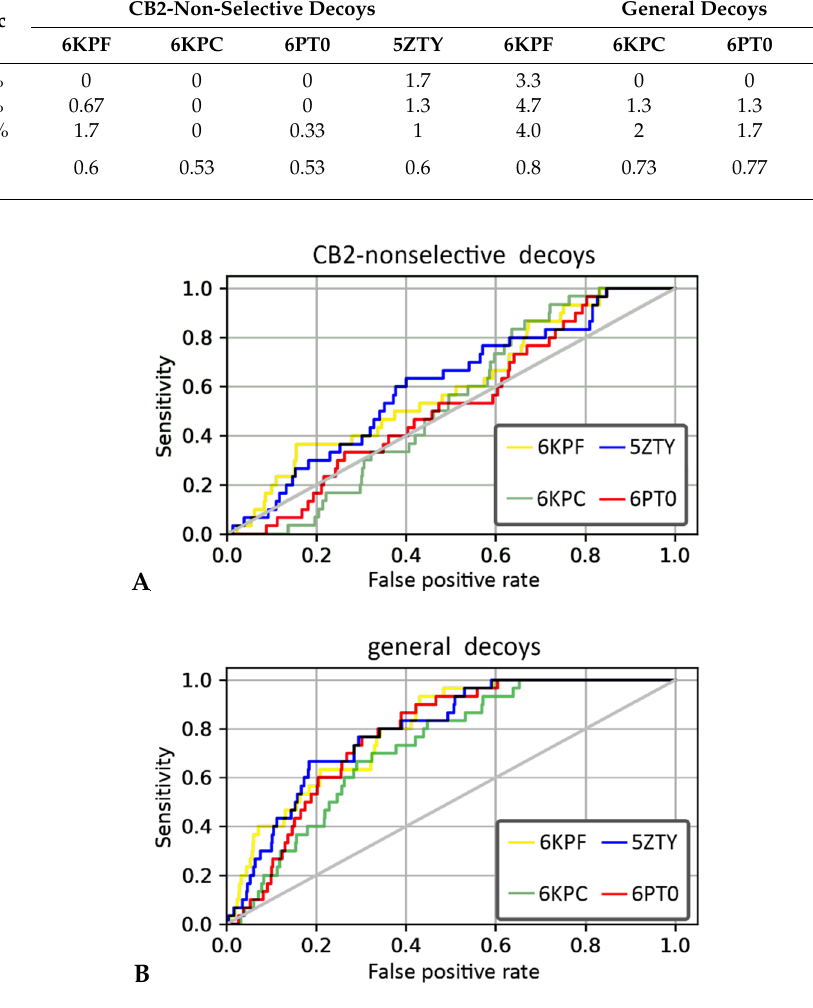
Figure 6. The receiver operating characteristic (ROC) curves obtained in the enrichment study using libraries including ( A ) CB2-selective and CB2-non-selective ligands and ( B ) CB2-actives and CB2-non-active ligands.